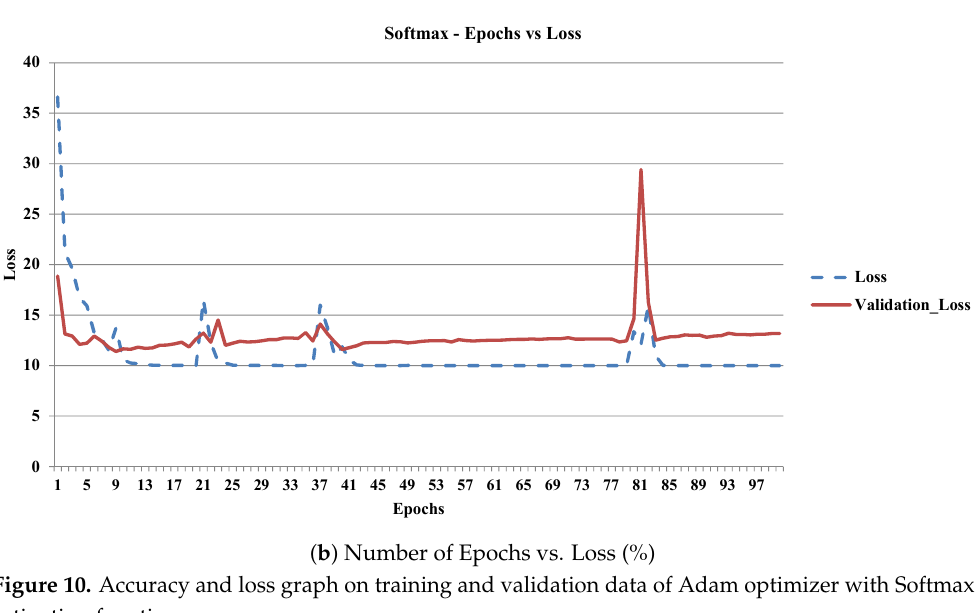
Figure 10. Accuracy and loss graph on training and validation data of Adam optimizer with Softmax activation function.